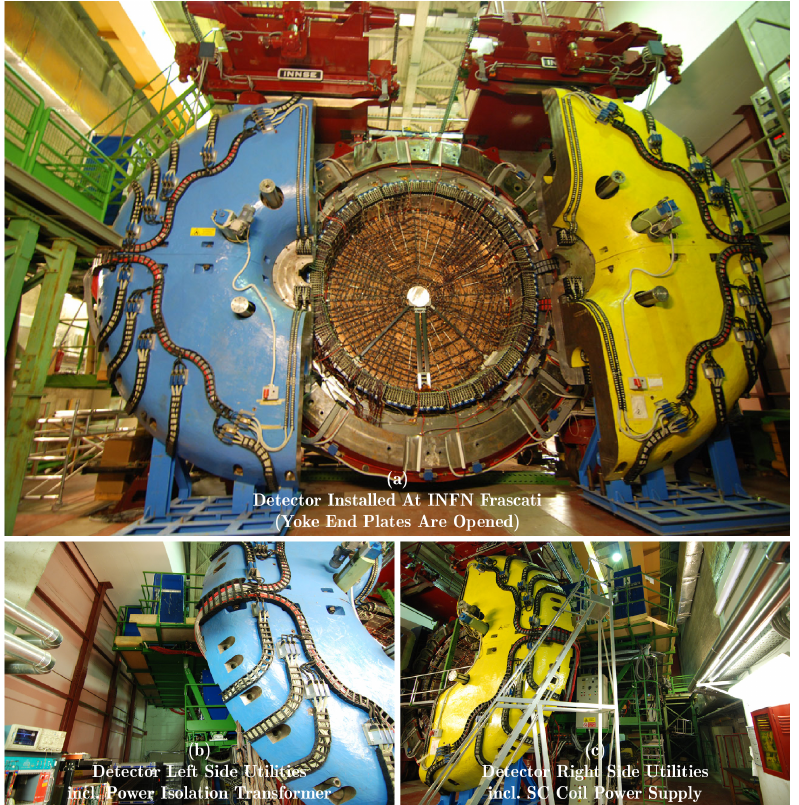
Figure 173. Parts of an existing detector (KLOE, which is currently installed at INFN Frascati, Italy) will be repurposed for use in the SAND beam monitor.